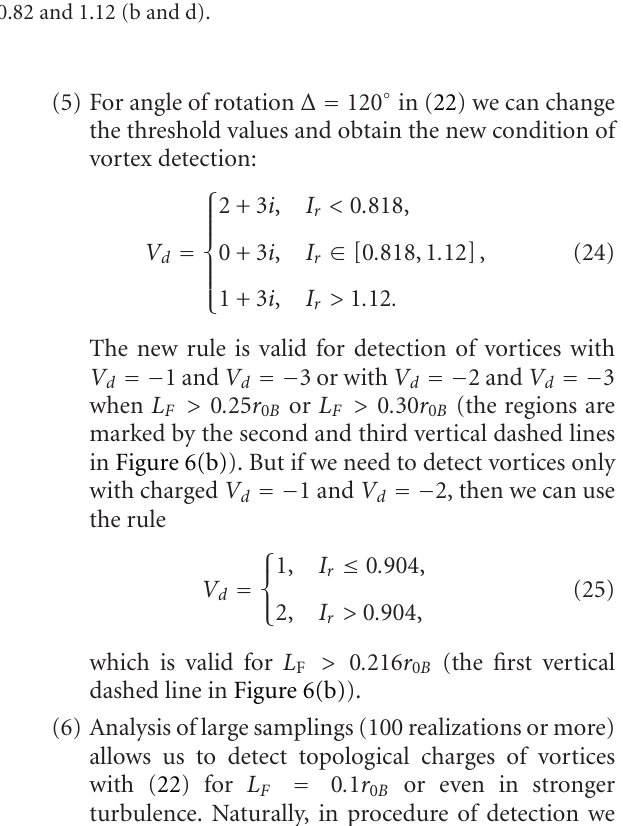
L = 0 . 25 r = 0 . 1 r F 0 B (a, c) and F 0 B (b,d). The uppermost and bottommost